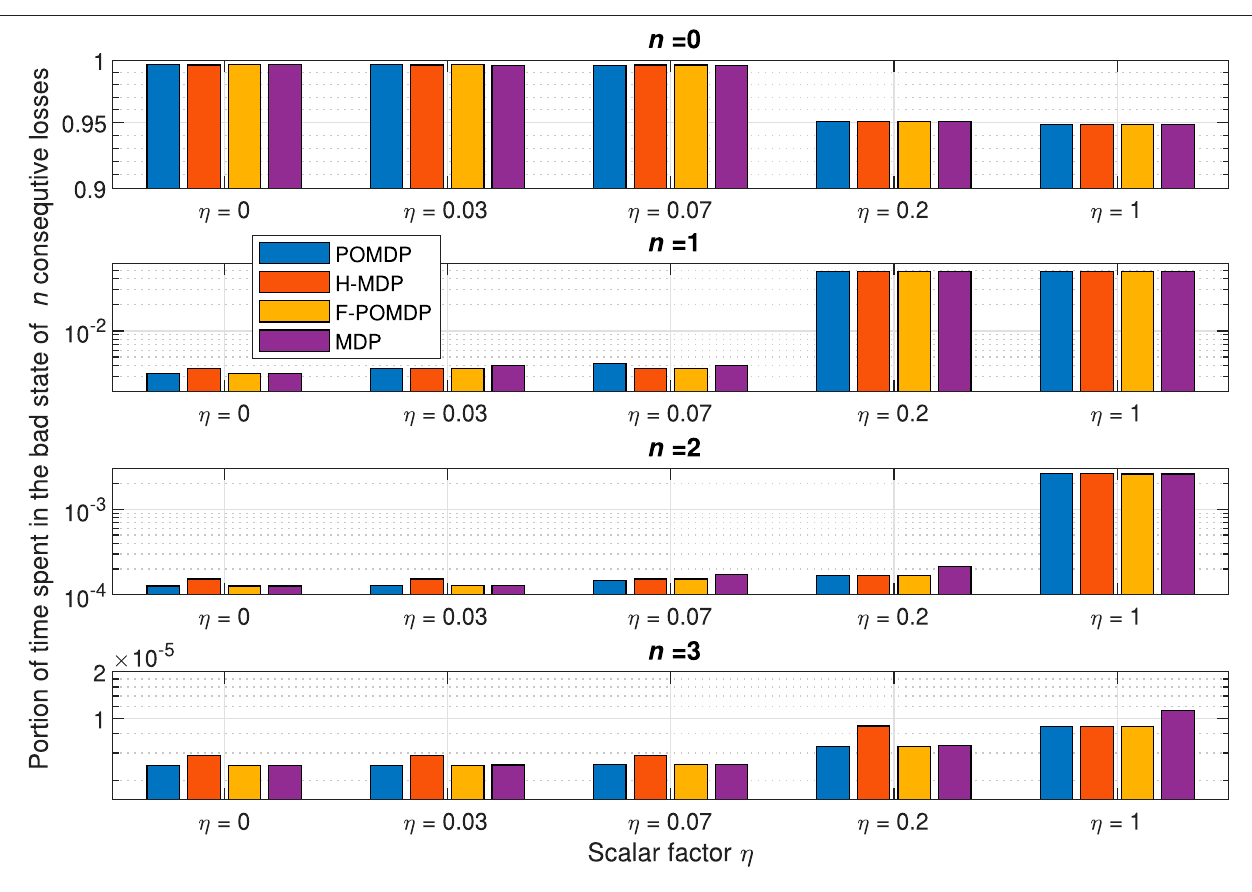
FIGURE 6 | Portion of time spent in the state with n consecutive untimely packets for all simulated and analytically extracted data.